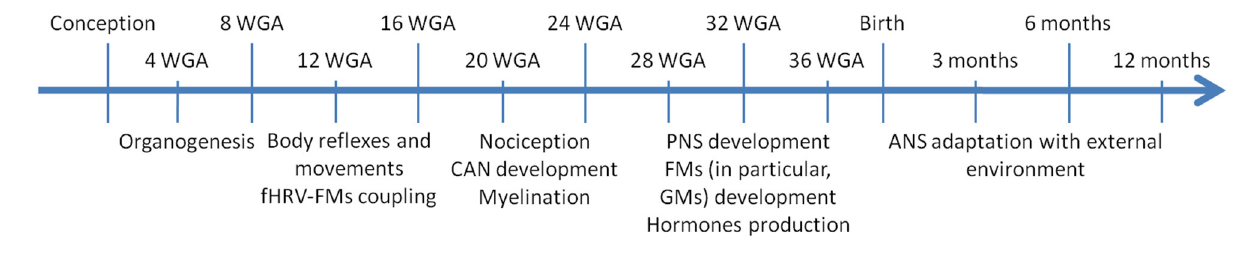
Frontiers in Neuroscience |